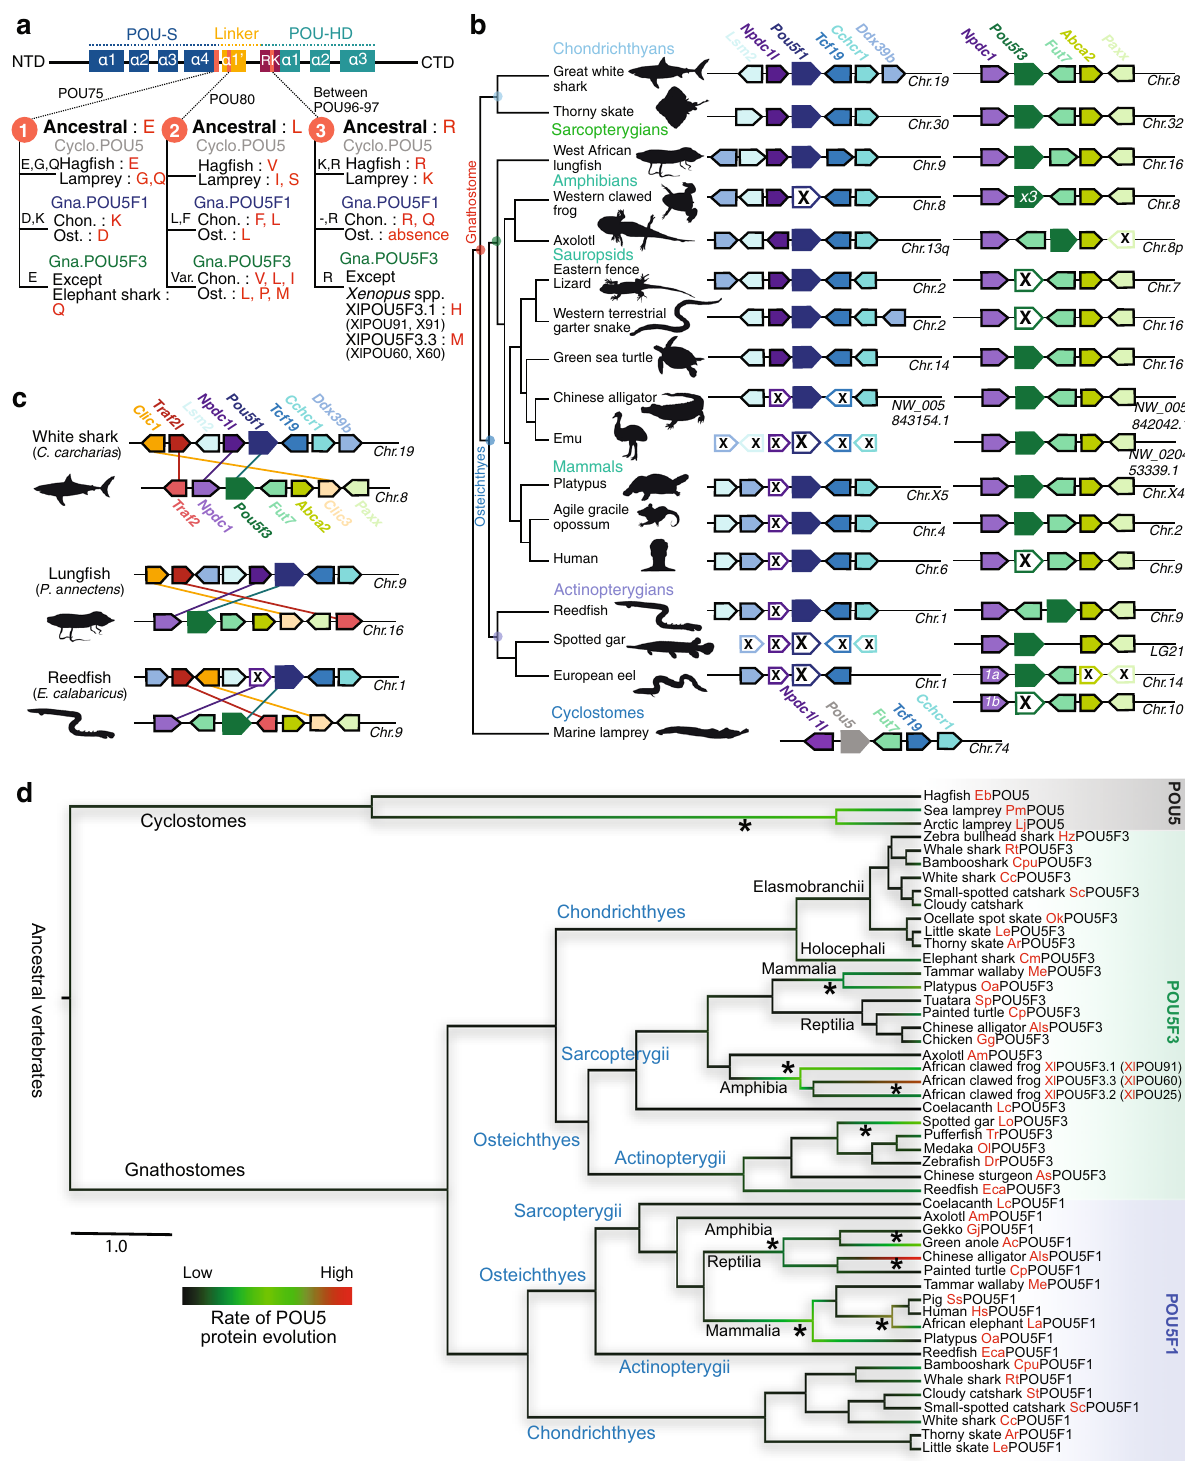
retention in actinopterygians (except reed fi sh), anurans (e.g. frog) and birds (e.g. emu) and (iii) independent Pou5f3 losses/ Pou5f1 retention in eutherians (e.g. human and mouse) and squamates (e.g. lizard and snake) (Fig. 1b; Supplementary Fig. 2). It also resolves the timing of paralogue loss/retention events with an increased reso- lution. For instance, we identi fi ed an unambiguous Pou5f3 coding sequence in the tuatara Sphenodon punctatus